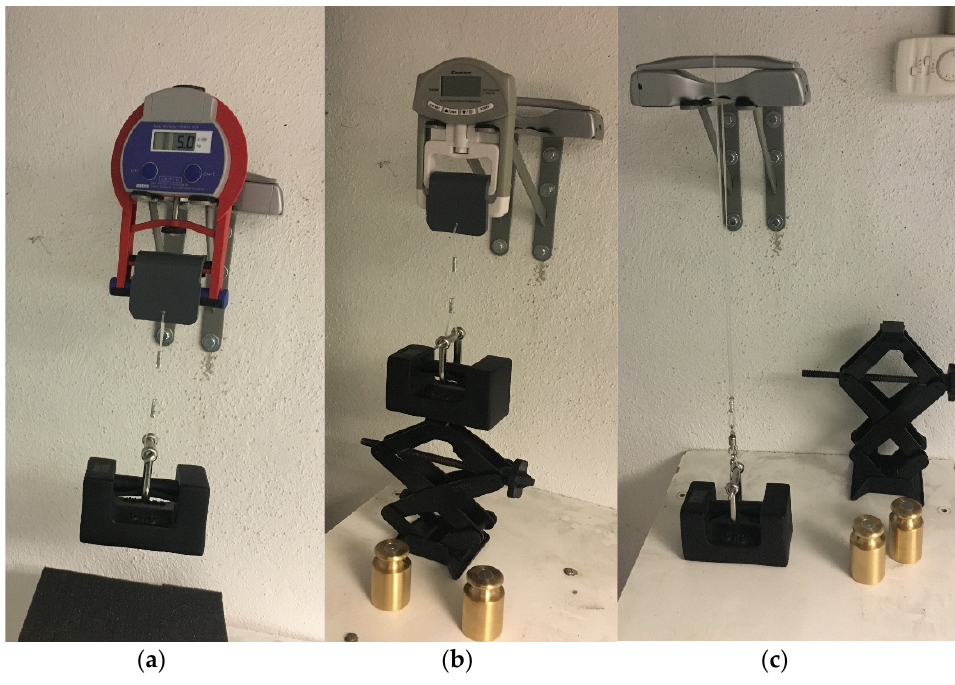
Figure 12. Dynamometers cargo system. ( a ) Takei 5101 TKK, ( b ) Constant 14192-709E, ( c ) hand grip device UIB